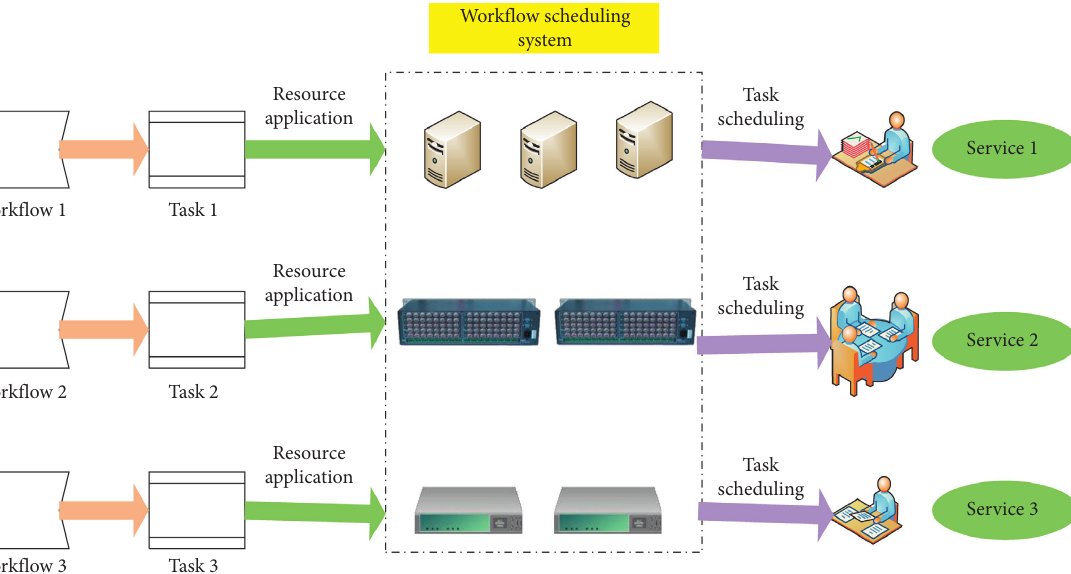
Figure 4: Workflow scheduling system.